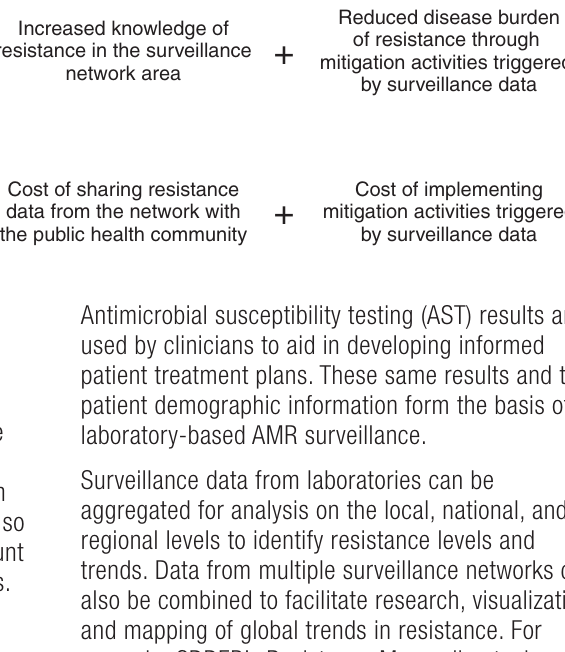
FIGURE A8.2. Theoretical Framework for a Cost-Benefit Analysis of Antimicrobial